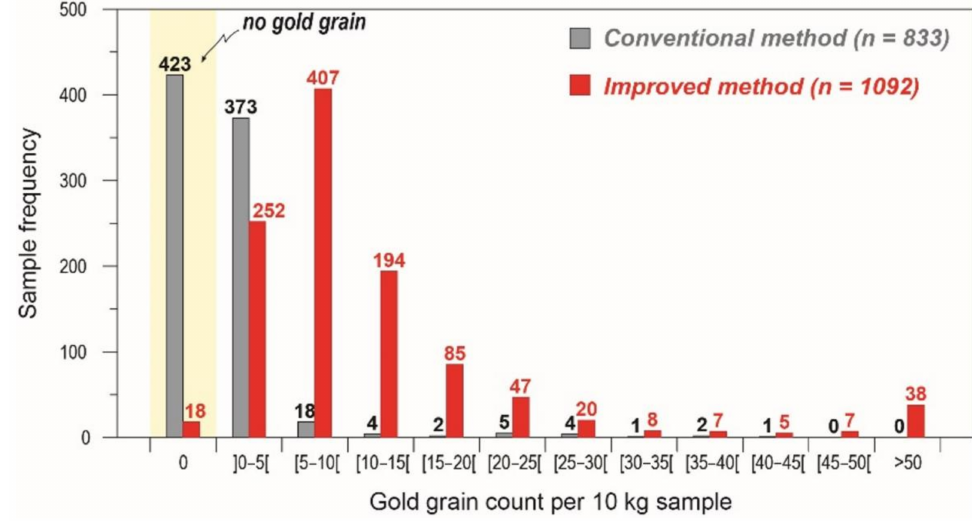
Figure 9. Comparison of the gold grain count per sample (normalized to 10 kg) obtained for the conventional and improved methods from till surrounding the Borden gold